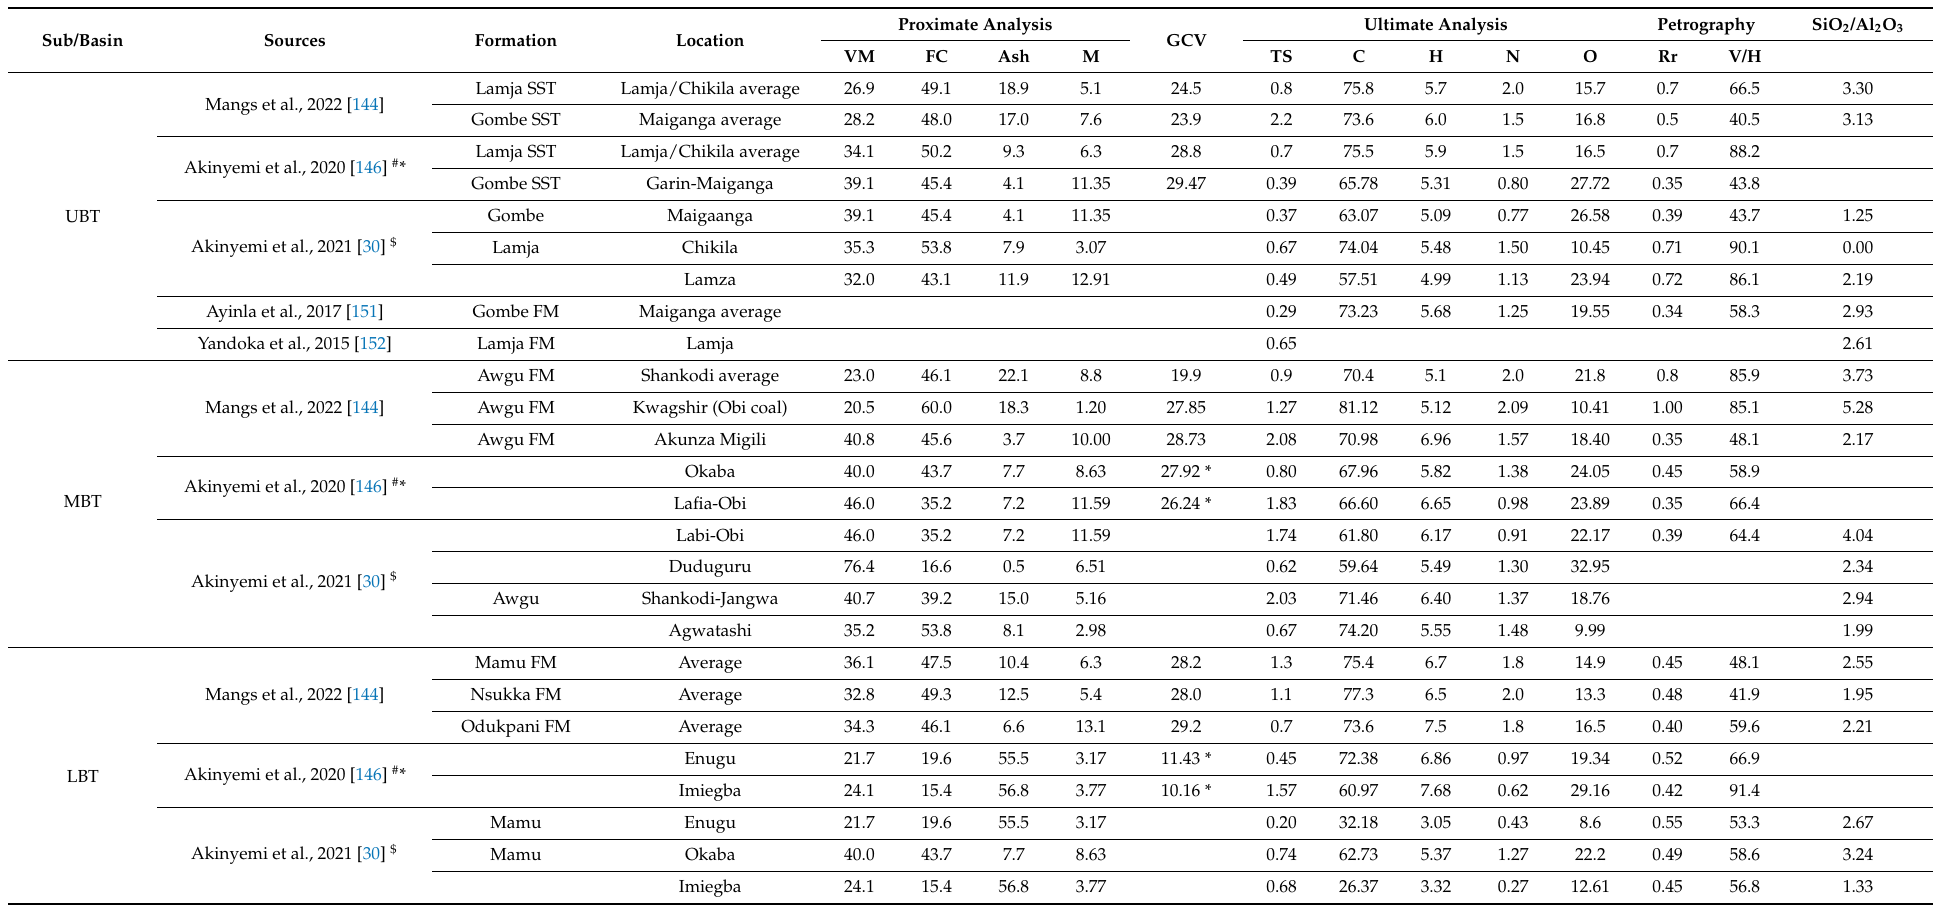
Table 7. Proximate (as received basis, %) and ultimate (dry and ash-free basis, %) analyses, high heating values (GCV, MJ/kg), petrography, and SiO 2 /Al 2 O 3 ratios for coals from